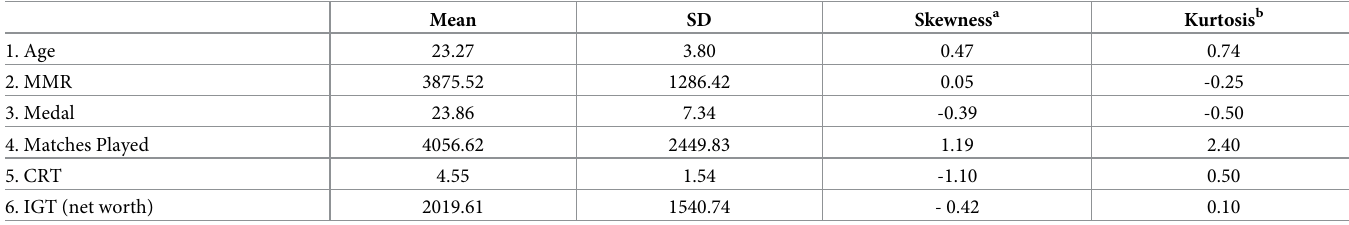
Table 1. Descriptive statistics of the study sample ( n =